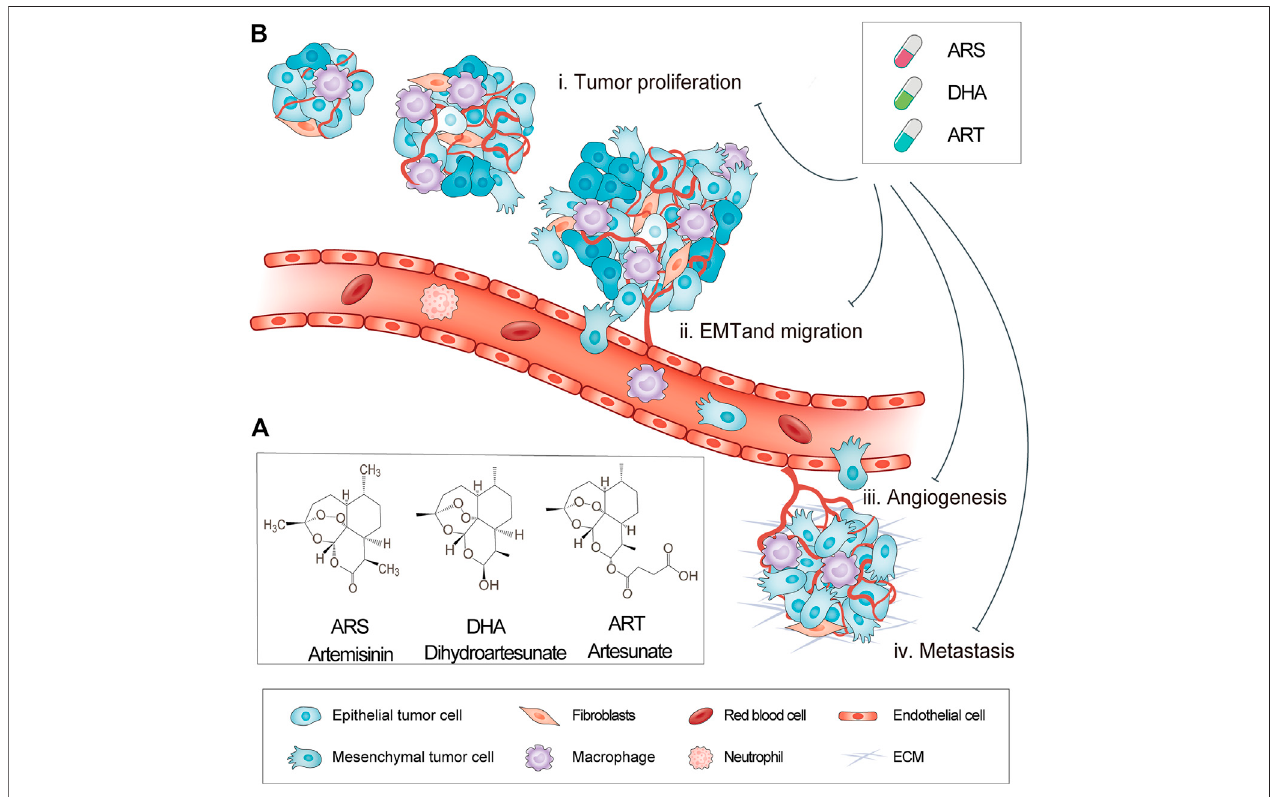
FIGURE 1 | Chemical structure and anticancer activity of artemisinins. (A) Chemical structure of artemisinins (B) Multifunctional anticancer activity of artemisinins.